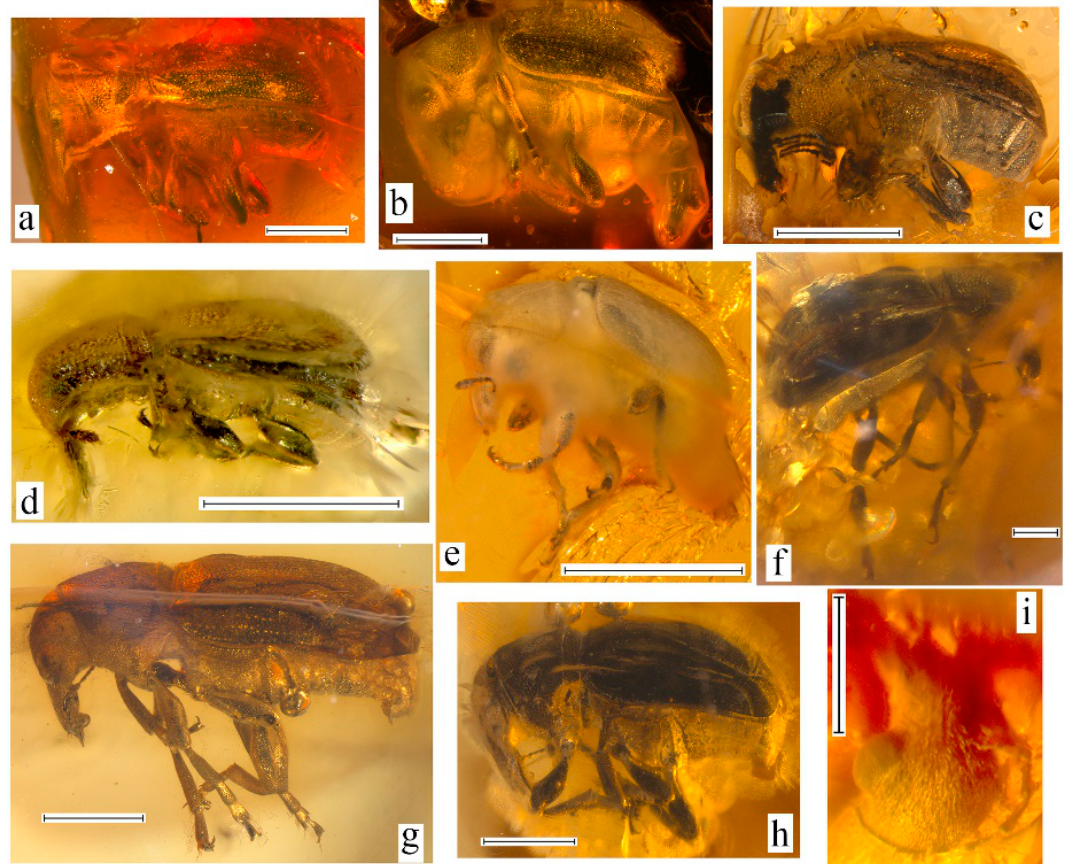
Figure 2. Habitus of Anthribinae from Baltic amber. ( a ) Glaesotropis minor , holotype, PIN , no. 964 / 801: body, laterally. ( b ) G. minor , paratype, PIN , no. 363 / 109, body, laterally. ( c ) G. alleni , holotype, ISEA , no. BA2012 / 19, body, laterally. ( d ) G. gratshevi , holotype, ISEA , no. BA2014 / 2, body, laterally. ( e ) G. zherikhini , holotype, ISEA , no. BA2011 / 2, body, laterally. ( f ) G. weitschati , specimen, CVGM , no. 027C10, body, laterally. ( g ) G. gusakovi , holotype, CVGM , no. 026C12, body, laterally. ( h ) G. succiniferus , holotype, CVGM , no. 028C13, body, laterally. ( i ) Pseudomecocerus alekseevi gen. et sp. nov. , holotype, KRAM , no. 6328, rostrum and head, dorsally. Scale bars: 1.0 mm. See Section 2 for names of collections.